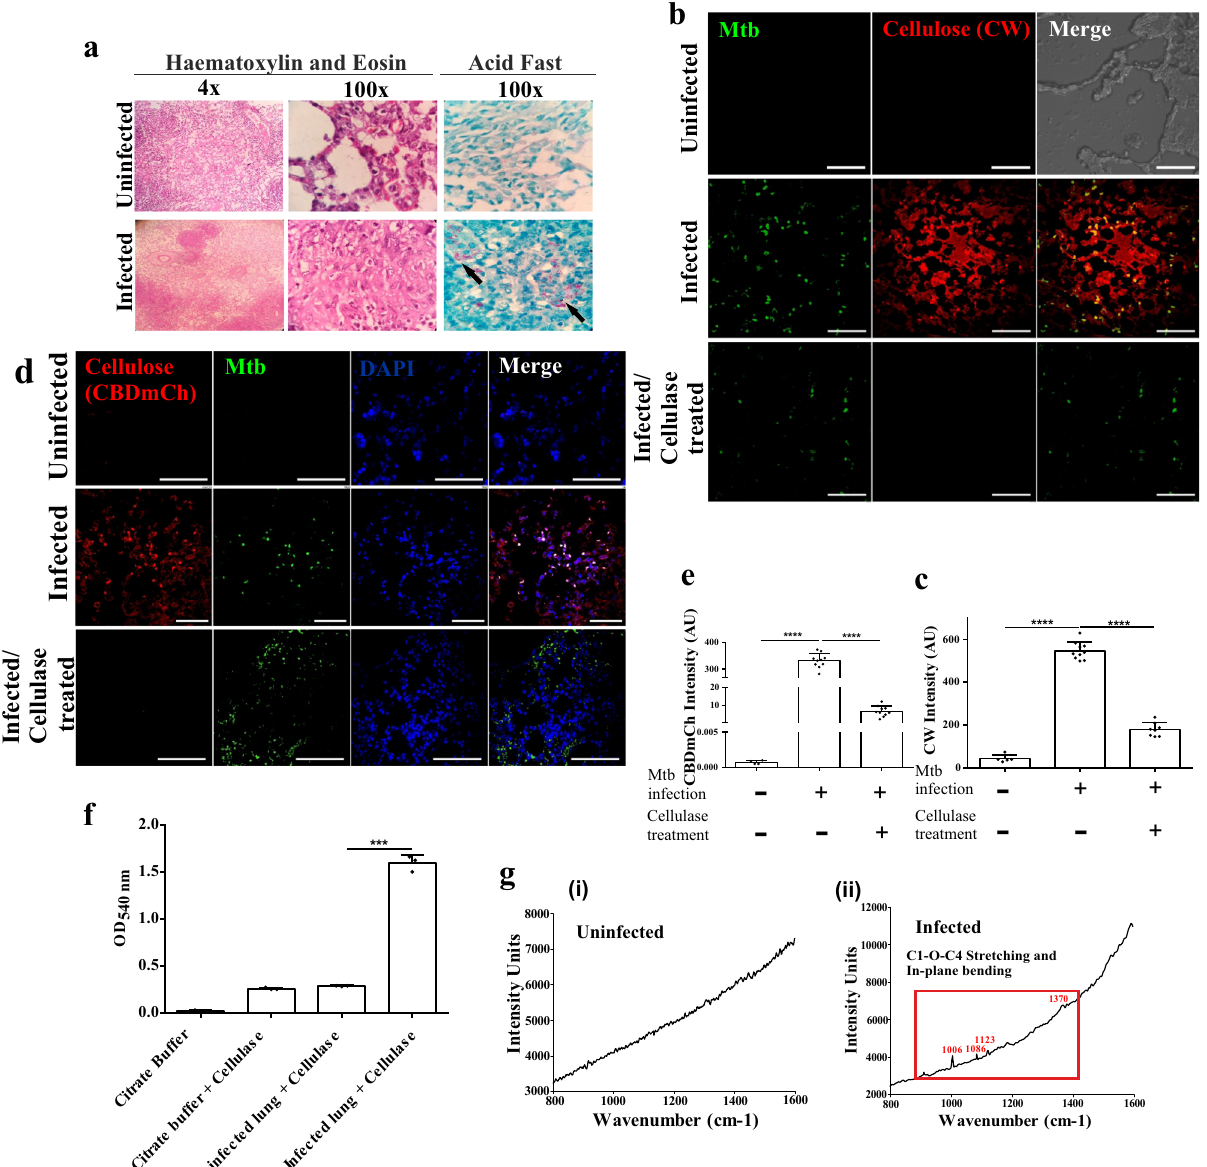
Fig. 6 Mtb forms bio fi lms inside the lungs of non-human primates. a Histopathology of granulomatous lesions in the lungs of Mtb infected rhesus macaques in contrast to uninfected ones, as indicated by H & E staining. Clusters of acid-fast bacilli are indicated by arrows. b , c Cellulose staining with CW and corresponding quantitation (using NIS elements) of Mtb infected, uninfected and Cellulysin cellulase treated lung sections of rhesus macaques showing Mtb bacilli stained with Auramine B – Rhodamine O. d , e CBD-mCh staining for cellulose and subsequent quanti fi cation (using NIS elements) of Mtb infected, uninfected and Cellulysin cellulase treated lung sections of rhesus macaques showing Mtb bacilli (stained with Auramine B – Rhodamine O). f DNS assay of cellulase treated lung tissue blocks from uninfected and Mtb infected rhesus macaque. g Raman microscopy of ( i ) uninfected and ( ii ) Mtb infected rhesus macaque lung sections showing cellulose speci fi c peaks in the infected lungs. The column bar graphs presented in fi gures c , e and f have been plotted in GraphPad Prism 6 and represented as mean (±s.e.m). Statistical signi fi cance was determined using Student ’ s t -test (two tailed). For c **** P < 0.0001, for e **** P < 0.0001 and for f *** P < 0.0001. All data are representative of three independent biological experiments performed in triplicates. Scale bars correspond to 50 μ m. All source data are provided as a Source Data fi